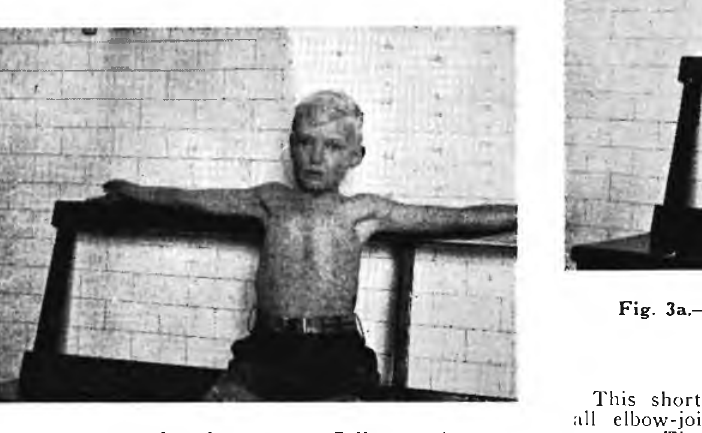
Fig. 3.—3 months after injury— Full extension recovered.